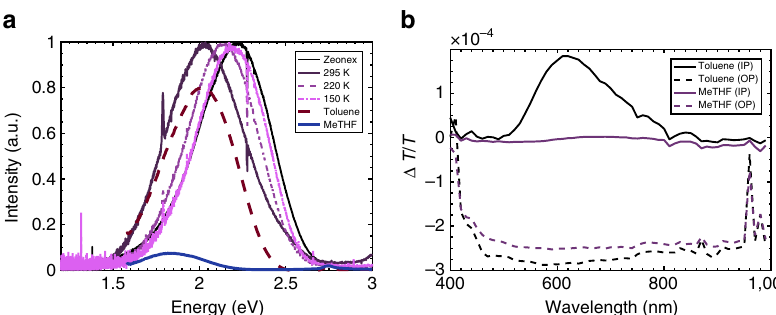
Figure 3 | Photoluminescence in solid state and solution with photoinduced absorption in solution of DPTZ-DBTO2. ( a ) Photoluminescence of DPTZ- DPTO2 in a variety of hosts at room temperature unless otherwise stated. The toluene and MeTHF solutions (2 (cid:4) 10 (cid:3) 5 M) were excited at l ex ¼ 400nm and the samples of ZEONEX and PEO (at 295, 220 and 150K) were excited at l ex ¼ 375nm. The reduction in magnitude for MeTHF is polarity related, while the shift of emission in PEO is related to the glass transition temperature. ( b ) The PIA of DPTZ-DPTO2 in toluene and MeTHF at concentrations of 10mM. The in-phase spectra (IP) are the solid lines and the out-of-phase (OP) the dashed lines. The broad absorption between 500 and 1,000nm is related to the 3 CT states.